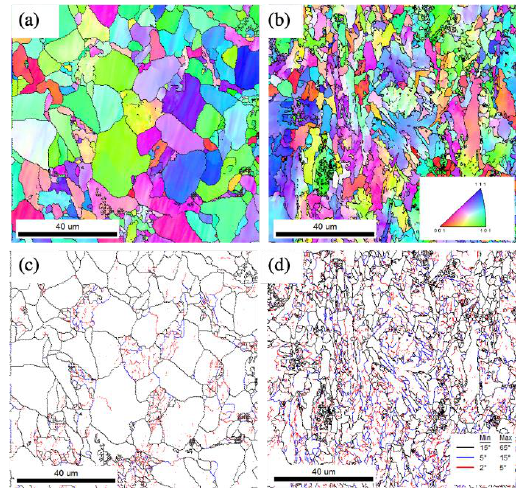
Figure 10. Inverse pole figure data and misorientation mapping of H0 ( a , c ) and H8 ( b , d ).